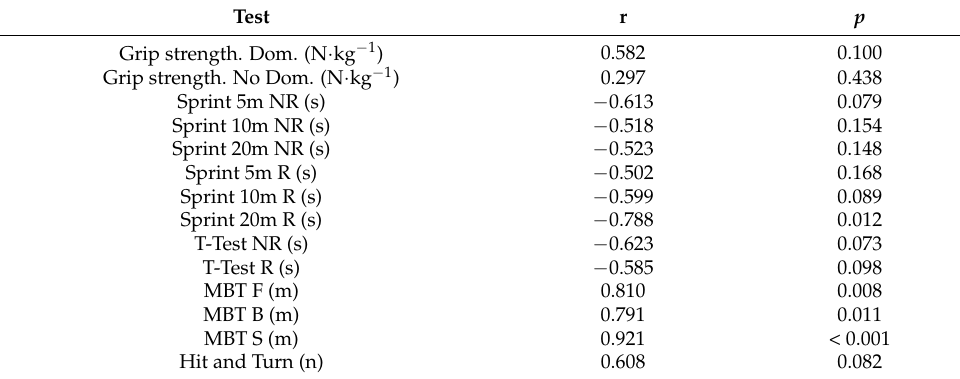
Table 4. Correlation coefficient of physical tests with serve velocity.